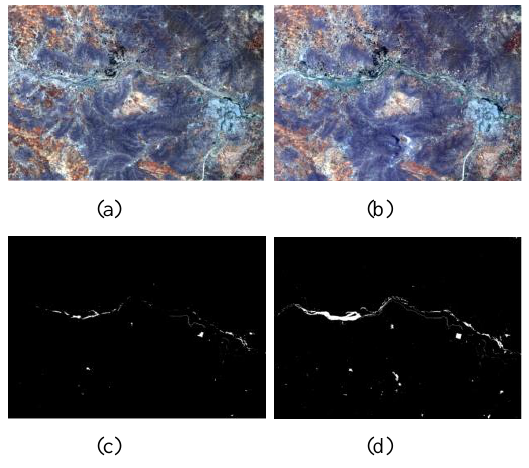
Figure 15: (a) Sub scene of Scene-2 (24-04-2017) (b) Sub scene of Scene-3 (27-04-2018) (c) proposed (24-04- 2017) (d) proposed